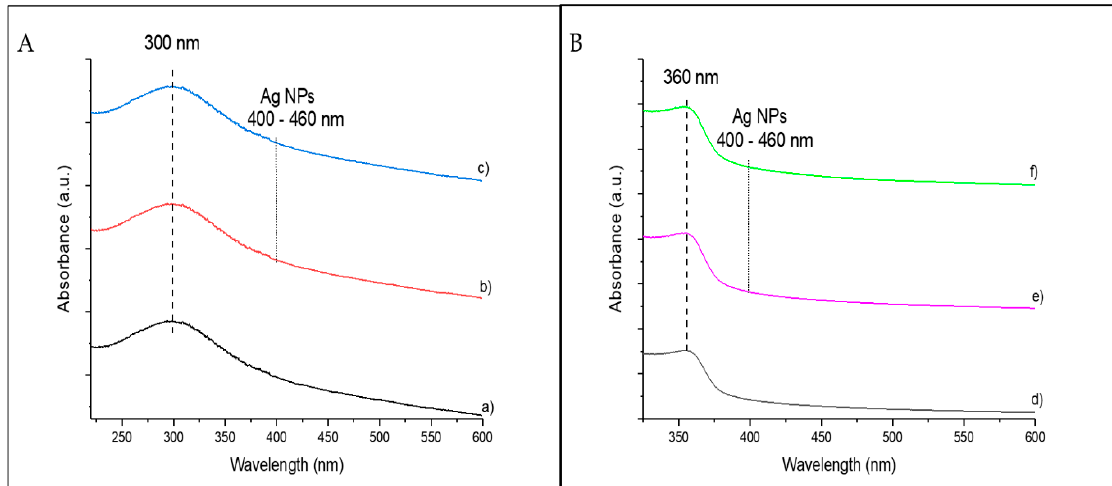
Figure 6. UV–vis spectra of TiO 2 NW ( A ,a), 10%Ag@TiO 2 -P25 ( A ,b), 10%Ag@TiO 2 NW ( A ,c), ZnO NW ( B ,d), 10%Ag@ZnO commercial ( B ,e), and 10%Ag@ZnO NW ( B ,f) catalysts. The region in which the presence of Ag NPs should be observed is indicated.